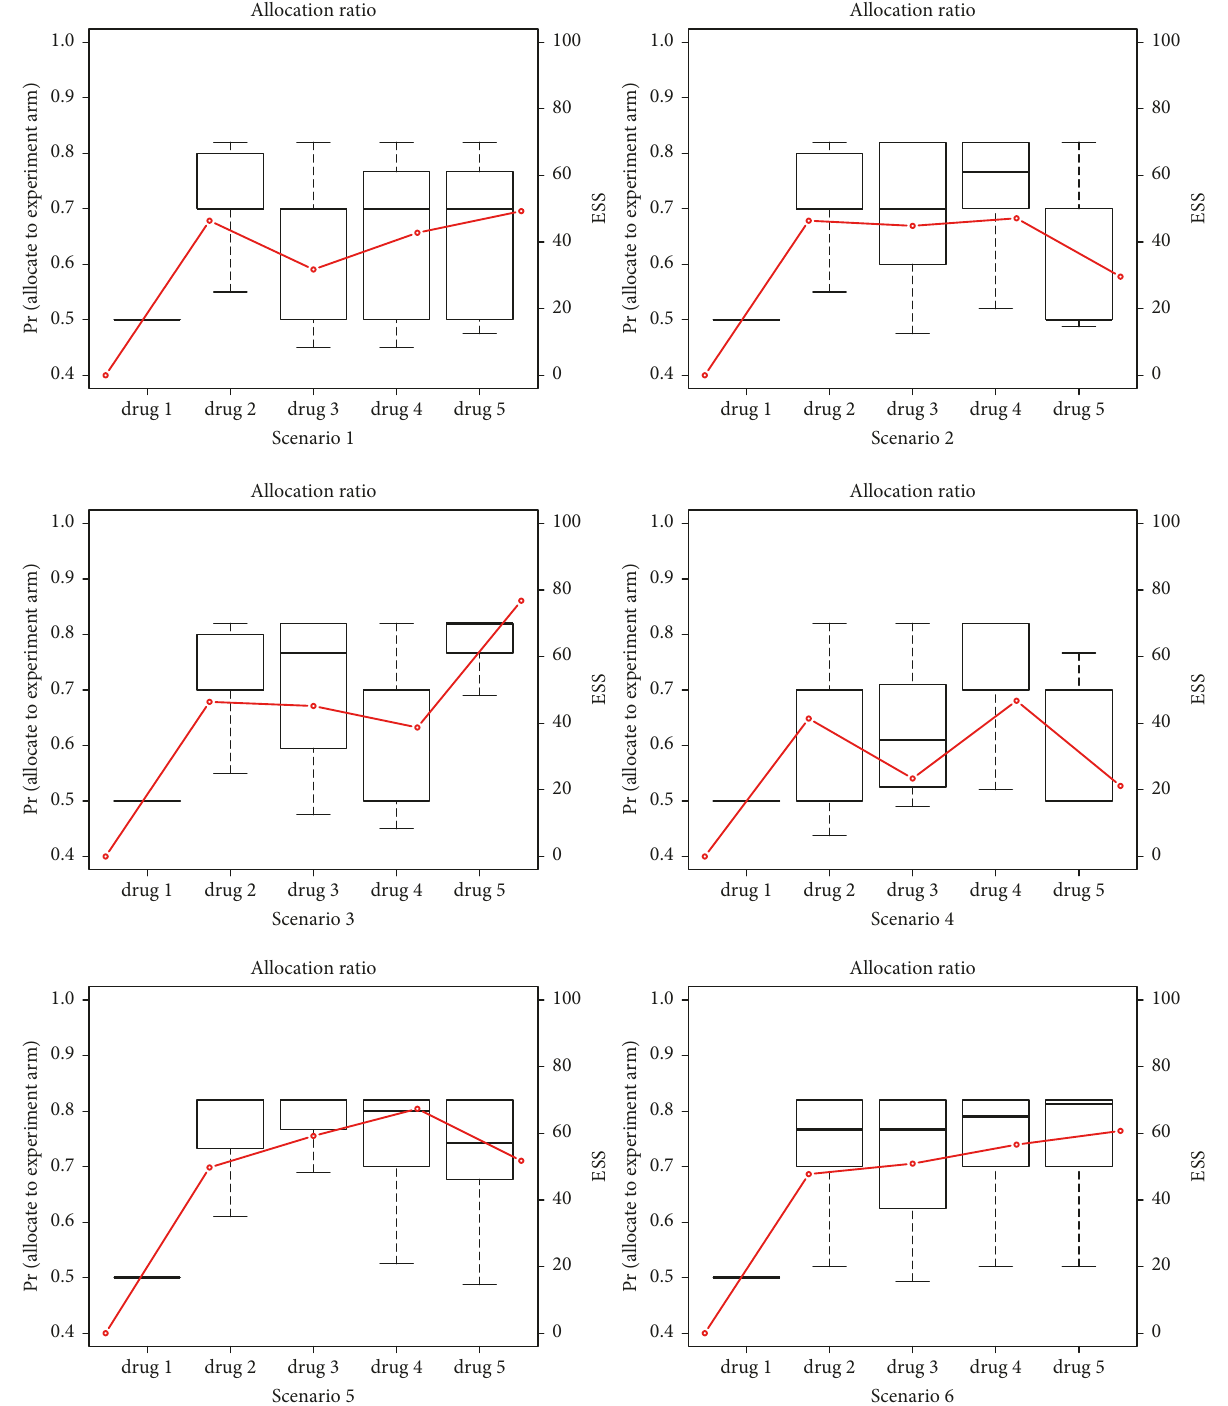
Figure 4: Proportion of patients assigned to the experimental arm and effective sample size in the optimal platform